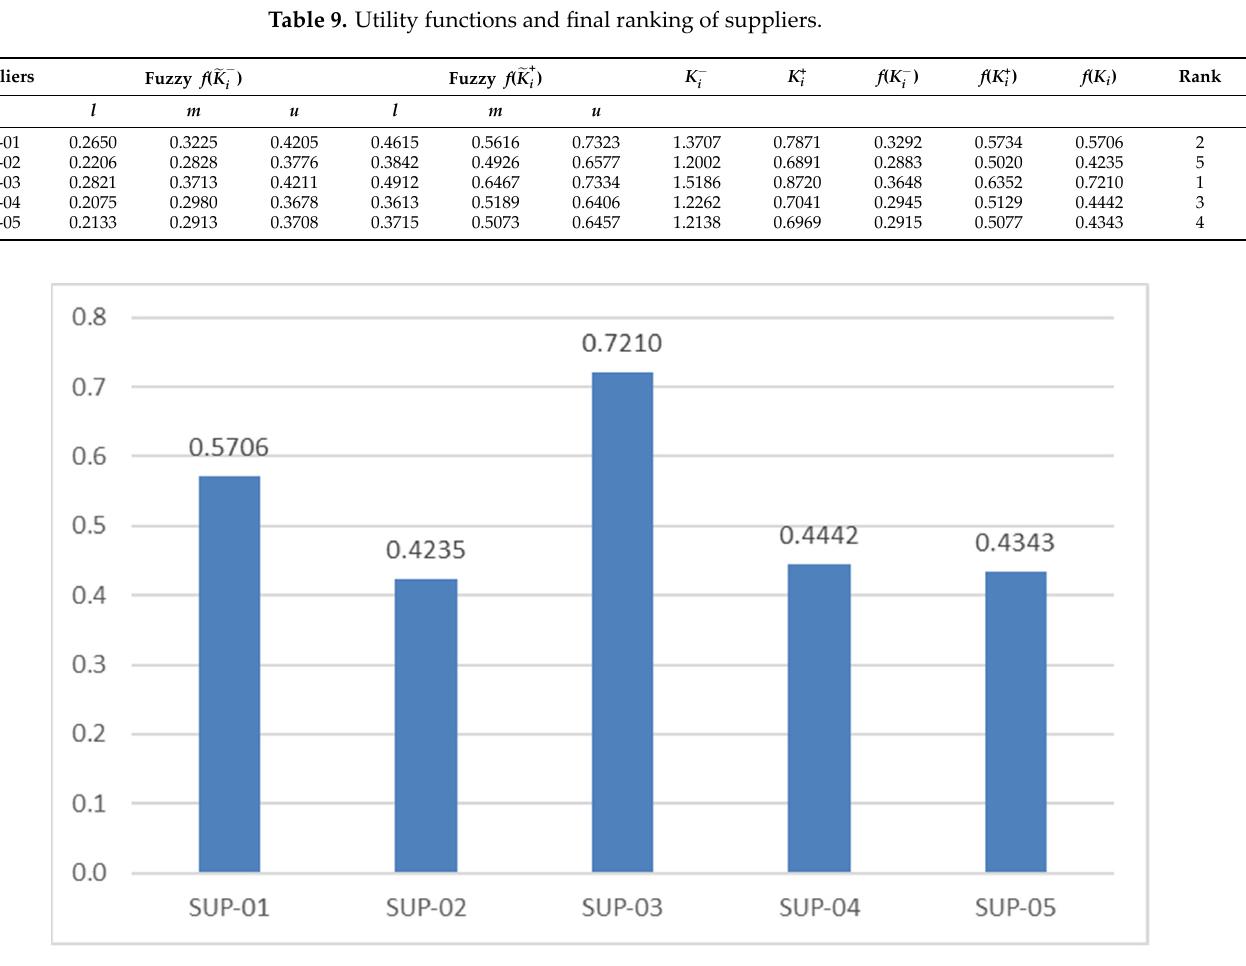
Table 8. Utility degree and fuzzy matrix of